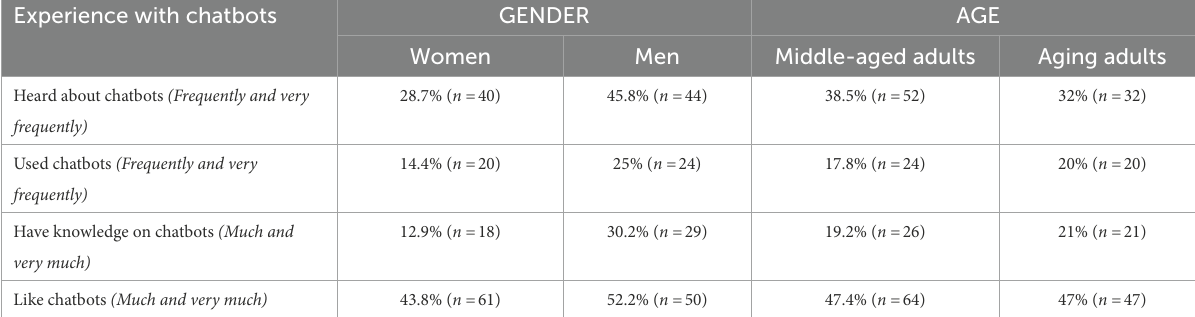
TABLE 3 A comparative summary on the previous experience with chatbots. Experience with chatbots